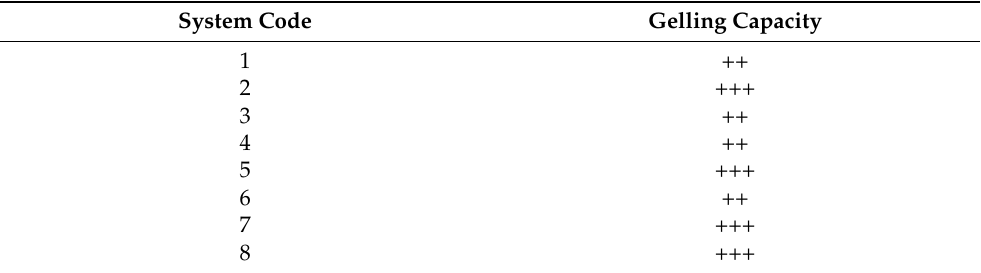
Table 3. Evaluation of gelling capacity for colloidal chitosan and HPMC E 5 LV systems.